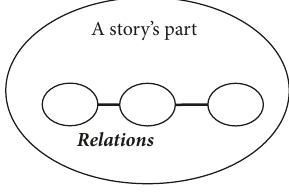
Figure 9: Connective actions.